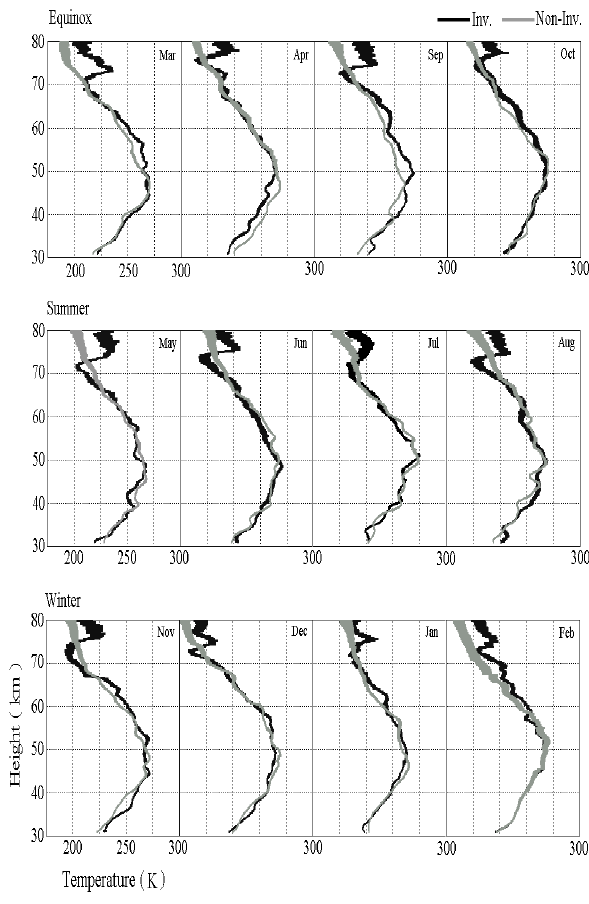
Fig. 2. Typical inversion day average temperature profiles, one for each month, along with the monthly average profile for the non- inversion days (gray colour